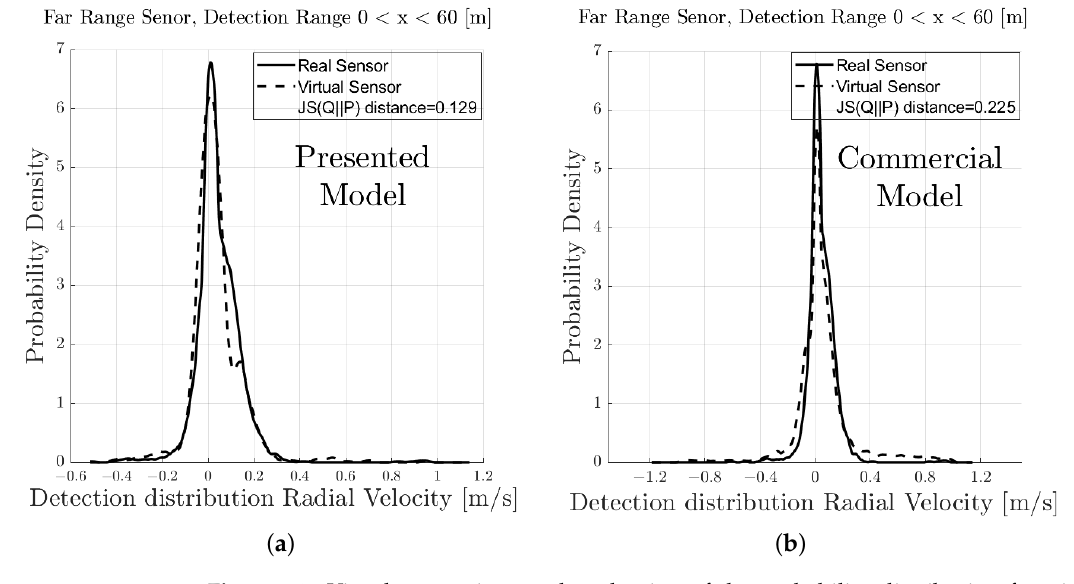
Figure 14. Visual comparison and evaluation of the probability distribution function (PDF) of the deviation of the measured and simulated radar point clouds with respect to the reference point P ( x , y ) in the near-range detection sector. ( a ) PDF of the radial velocity deviation from the reference ref velocity of the real sensor and sensor model presented in this paper. ( b ) PDF of the radial velocity deviation from the reference velocity of the real sensor and sensor model for commercial